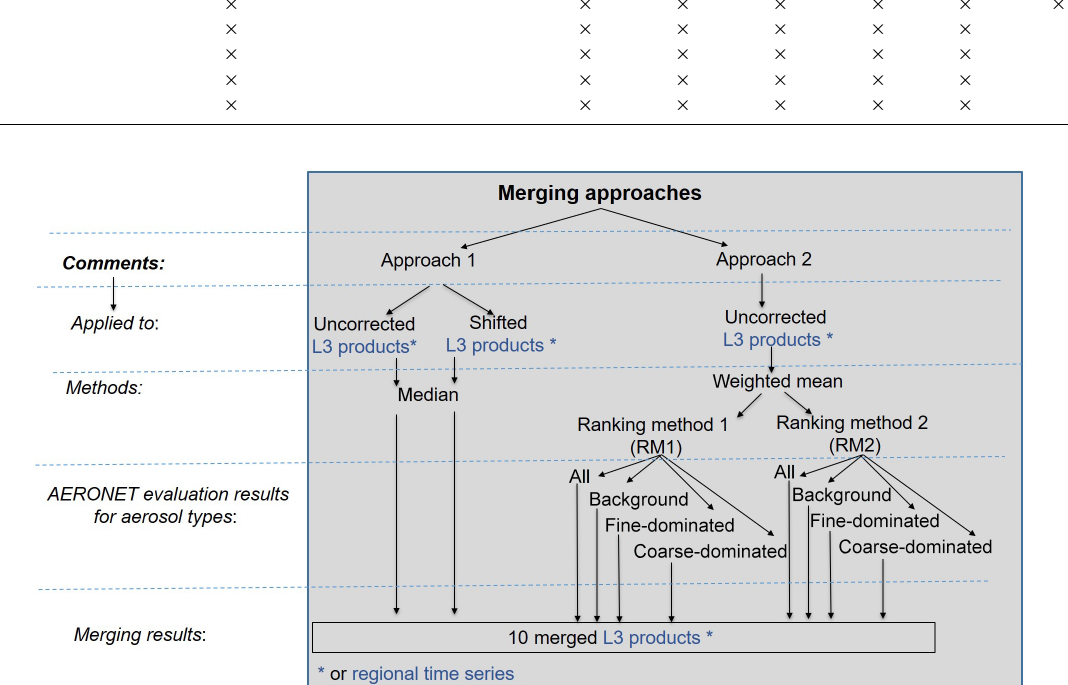
Figure 5. Scheme for the merging approaches; applied for L3 products or regional time series.